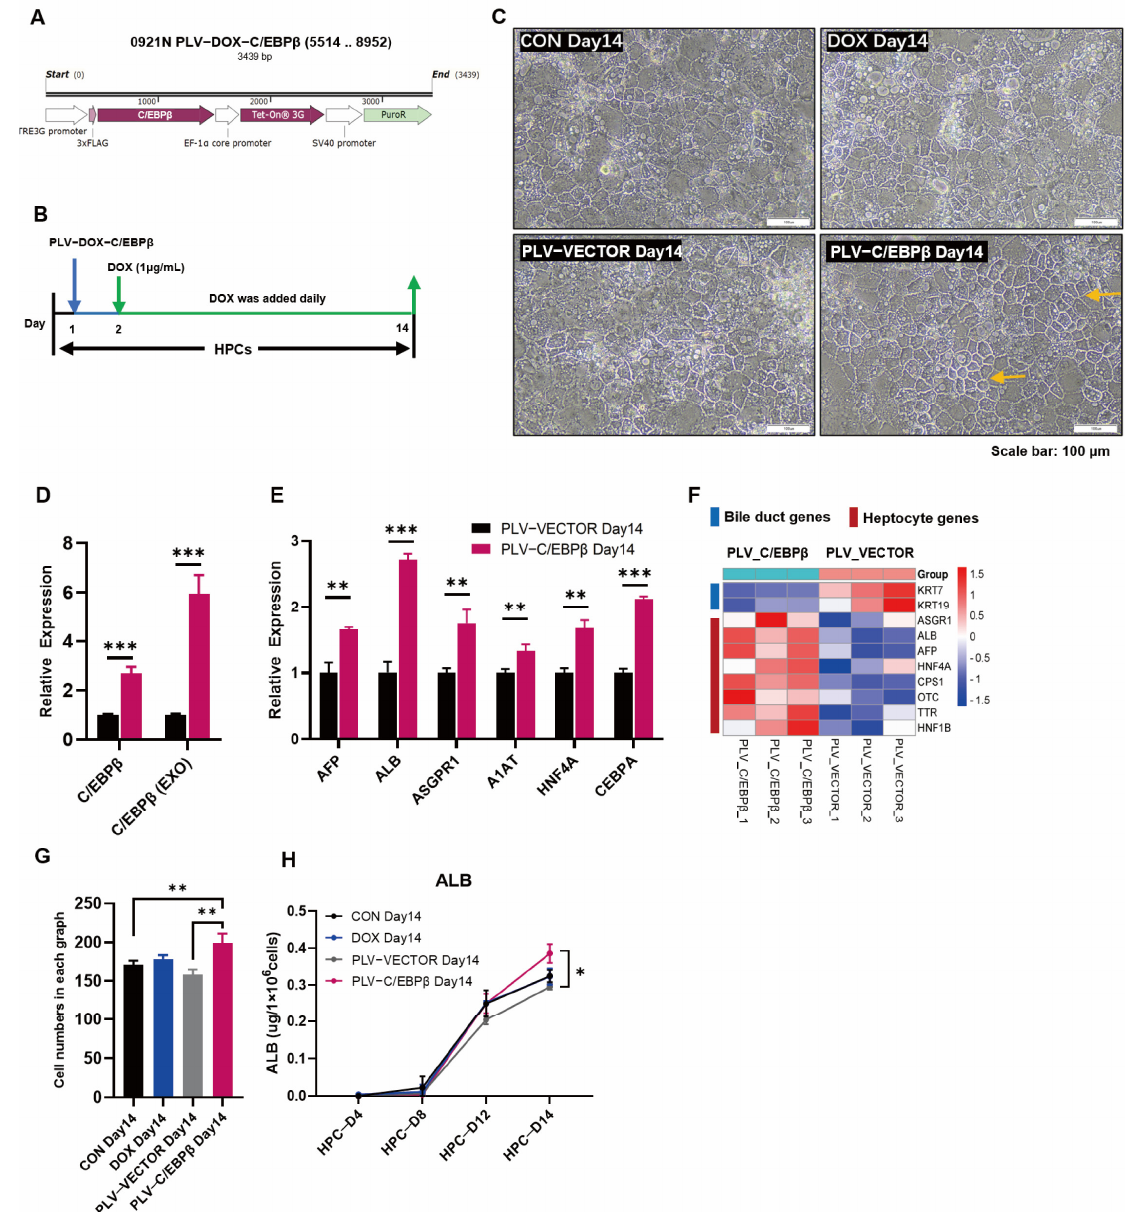
Figure 2. Enhanced expression of C/EBPβ promoted hepatic differentiation. ( A ) Schematic illustration of lentivirus vectors with overexpression of C/EBPβ. ( B ) Lentivirus vector-mediated overexpression of C/EBPβ by the administration of DOX during the hepatic differentiation. ( C ) Representative images of cell morphologies under different treatments, dense areas of cells are indicated by yellow arrows. ( D ) The overall C/EBPβ expression and exogenous C/EBPβ expression after the transduction with PLV-C/EBPβ virus and DOX administration (1 µg/mL). ( E ) Relative expression analysis of hepatocyte genes including AFP, ALB, ASGPR1, A1AT, HNF4A, and CEBP α in HPCs transduced with PLV-Vector or PLV-C/EBP β on day 14. ( F ) Heat map visualization of RNA-Seq data indicated that selected bile duct genes and hepatocyte genes were differentially expressed between HPCs transduced with PLV-Vector or PLV-C/EBP β on day 14. ( G ) Cell numbers were counted in each group in ( C ) and compared between different treatments. ( H ) ALB secretion was determined from the supernatants of HPCs with different treatments at different time points during the differentiation. Data represent mean ± SEM with p -values indicated when significant. p < 0.05 *; p < 0.01 **, p < 0.001